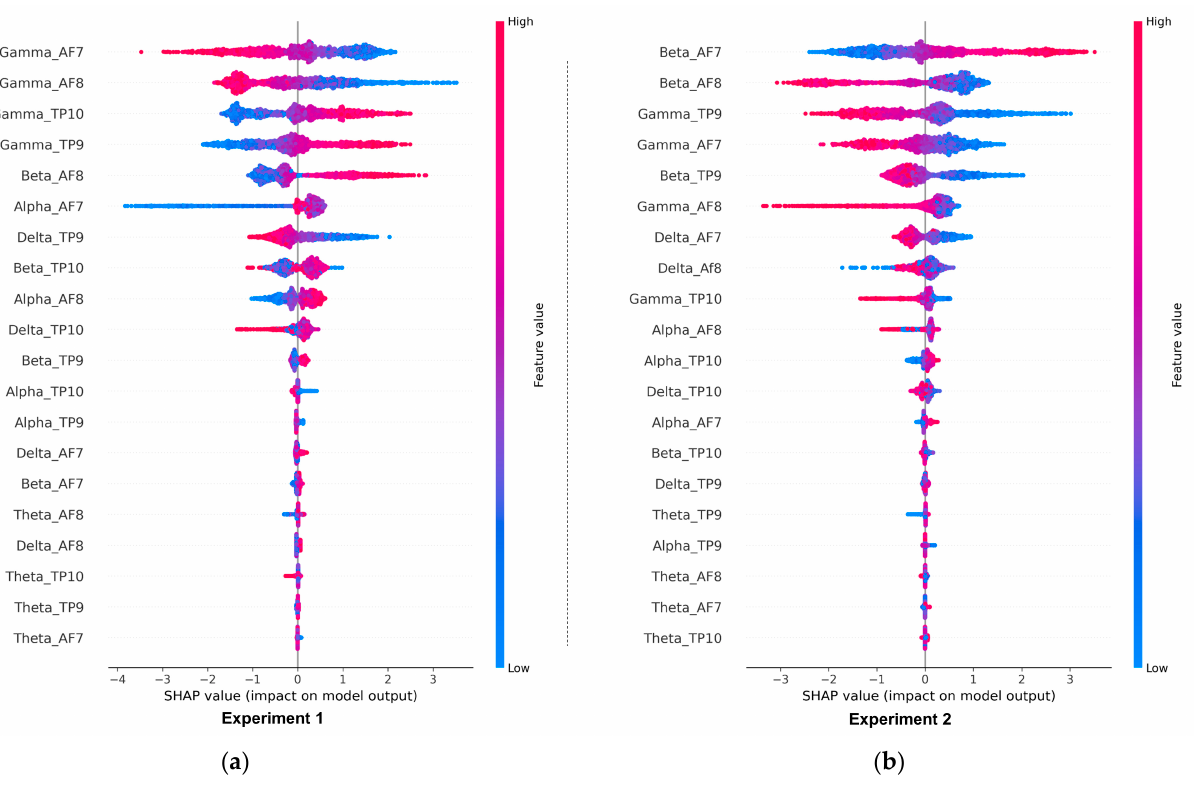
Figure 11. ( a , b ) Global feature importance of various EEG features in the proposed model (CNN- BiLSTM-CRF) for Experiment 1 and Experiment 2, respectively.